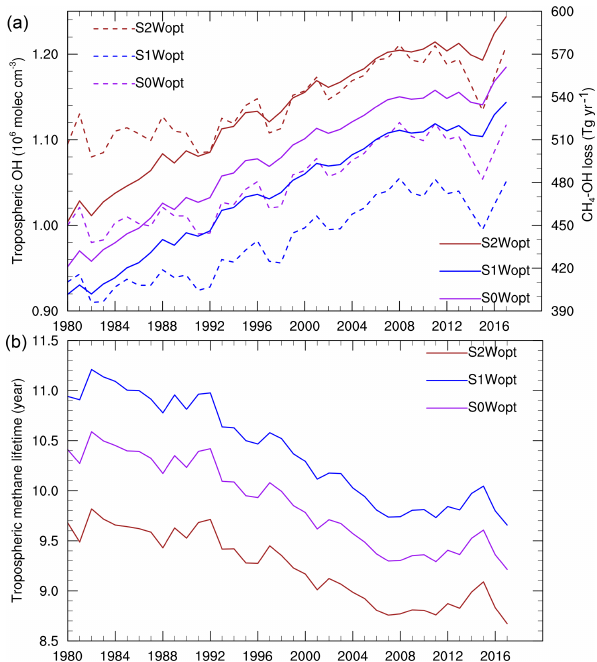
Figure 8. Time series of global tropospheric OH levels (left y axis, dashed line) and methane OH loss (right y axis, solid line) from S0Wopt (purple), S1Wopt (blue), and S2Wopt (brown) in panel (a) and time series of methane tropospheric lifetime from S0Wopt (pur- ple), S1Wopt (blue), and S2Wopt (brown) in panel (b)